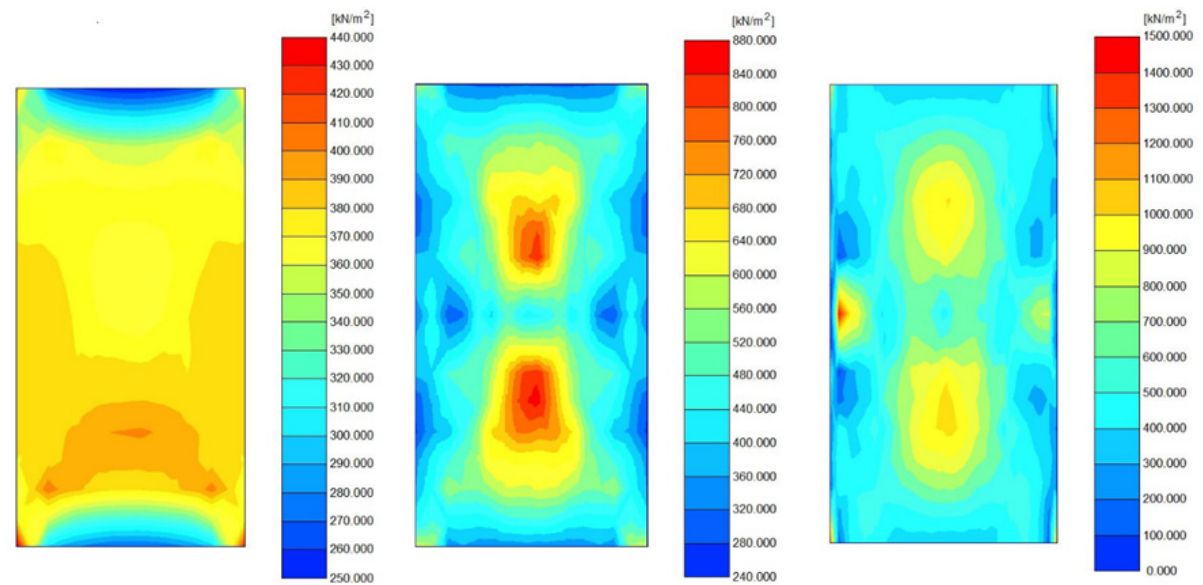
= 100 kPa: left – unreinforced sample; middle – 3